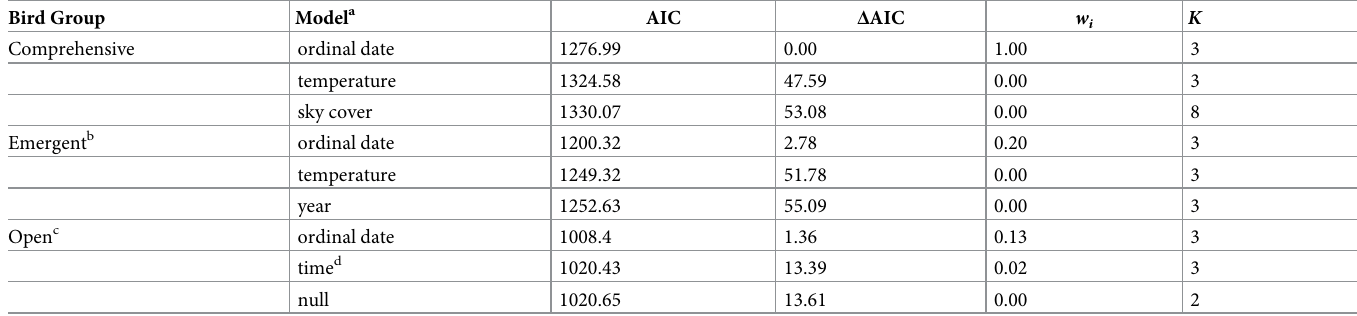
Table 2. Model rankings for variables predicting detection probability by species groupings of marsh birds based on Akaike’s Information Criterion (AIC), differ- ence in AIC relative to the highest-ranked model ( Δ AIC), relative model weight ( w i ), and number of parameters ( K ) from surveys conducted at wetlands throughout Illinois during late spring and early summer 2015–2017.